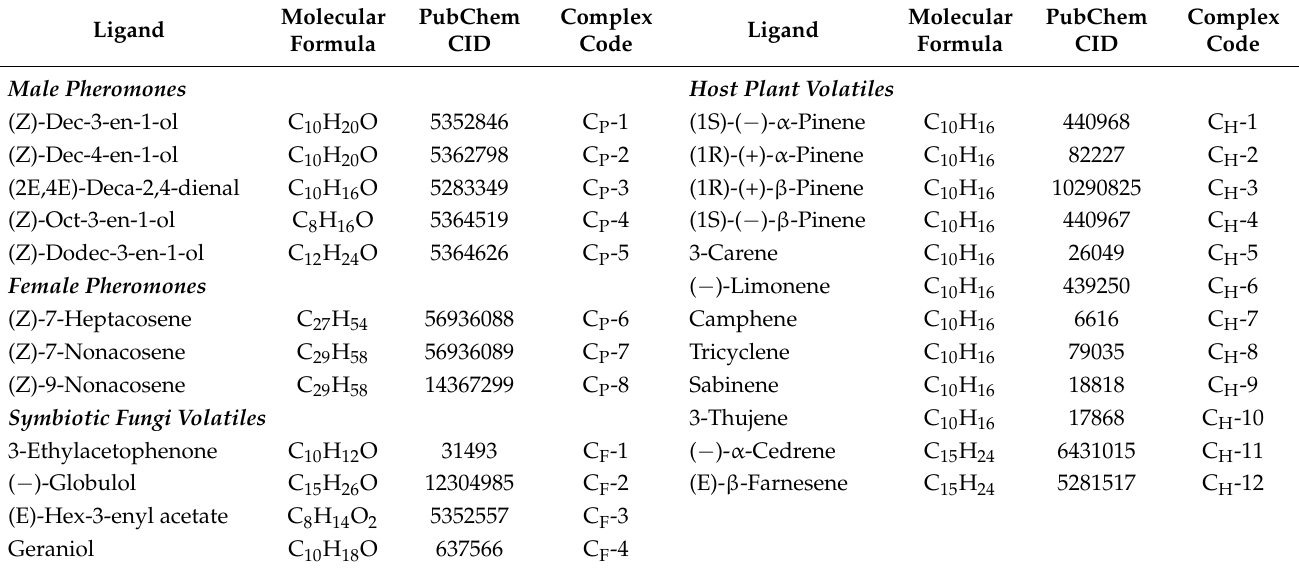
Table 2. Main information of 24